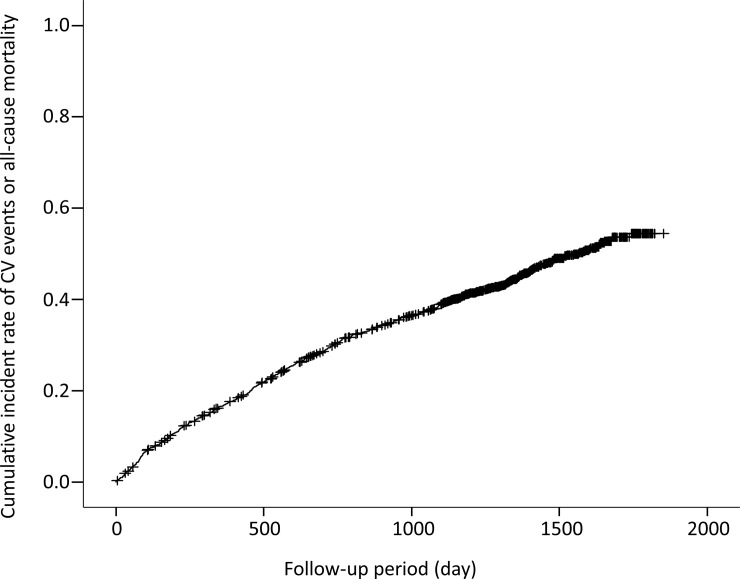
Cumulative incidence of cardiovascular events or all-cause mortality during follow-up period.